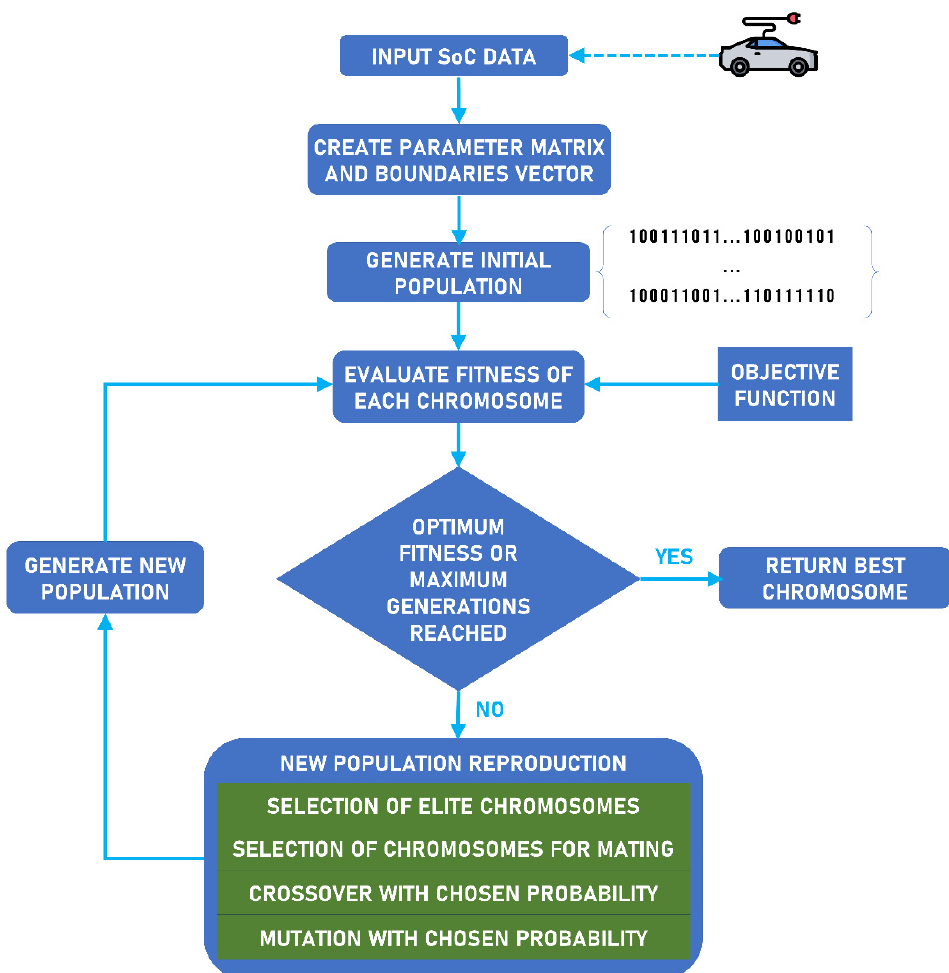
Figure 1. Flowchart of the program’s operation.